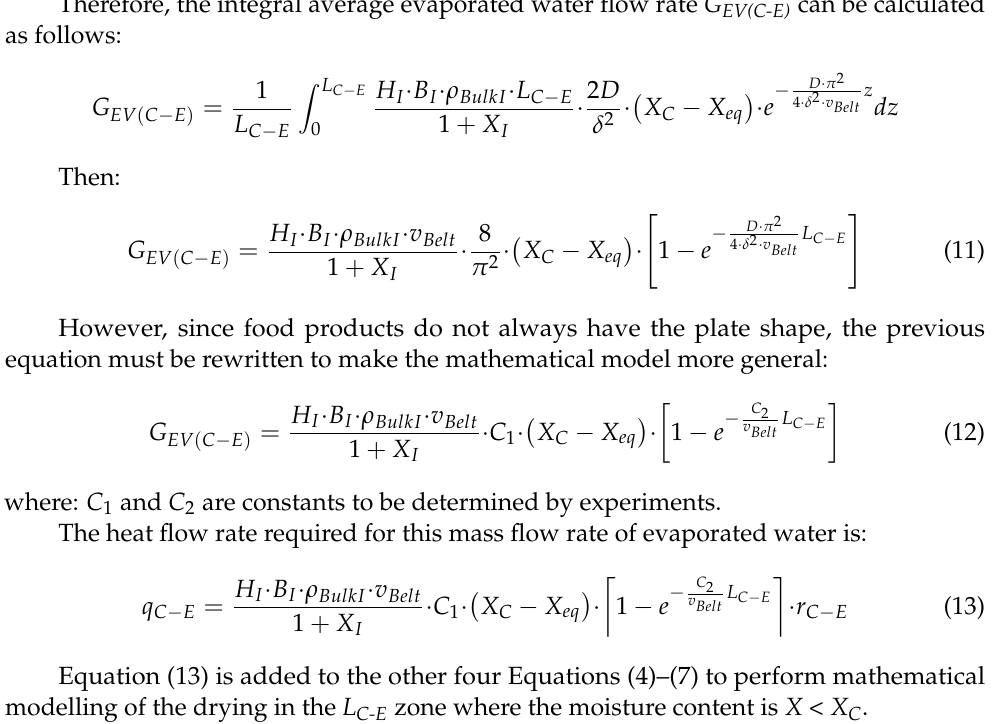
Figure 2. Mass flow rate of evaporated water G EV vs. z -coordinate within the L C-E zone, correspond- ing to the direction of the belt in the C-E zone where the moisture content is X < X C .